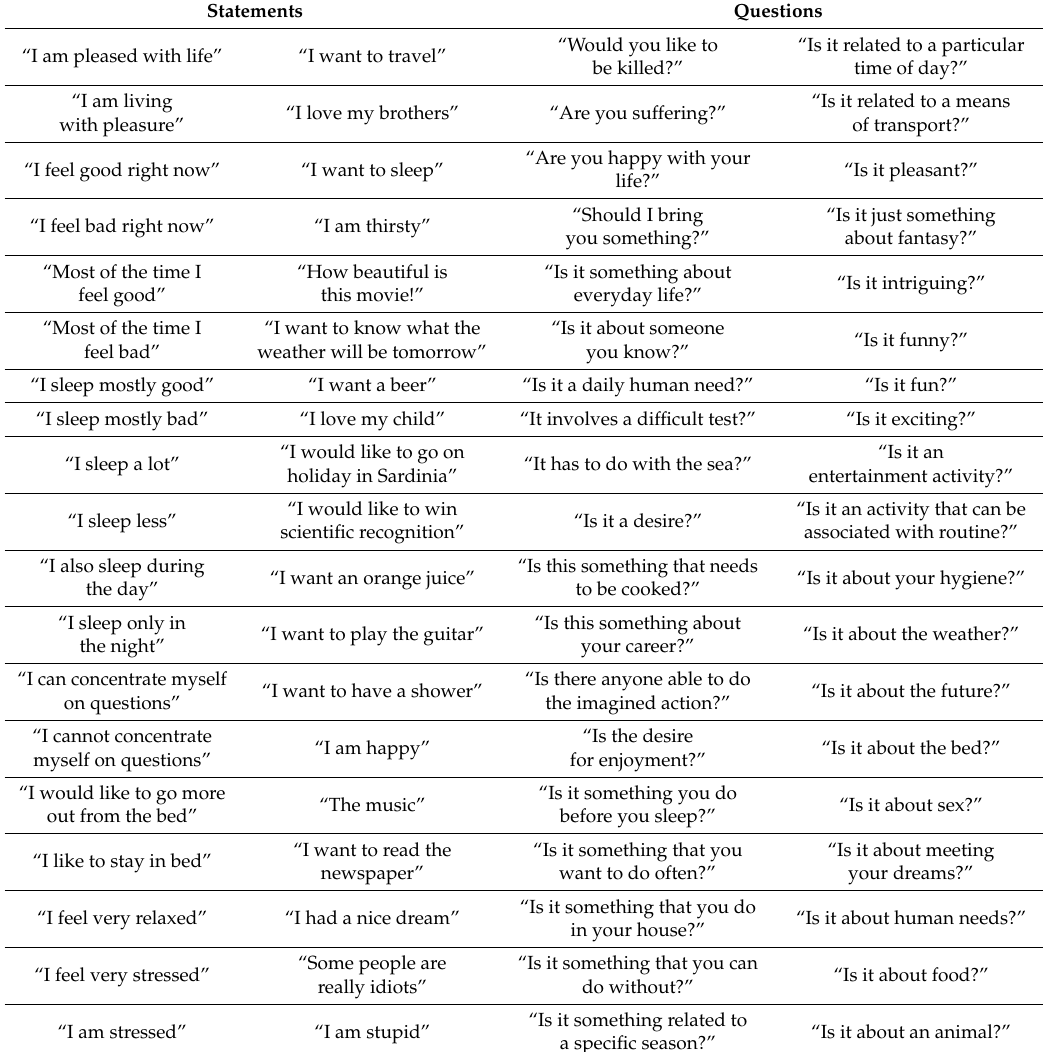
Table A1. List of statements and questions used for the online 20-questions-system and offline